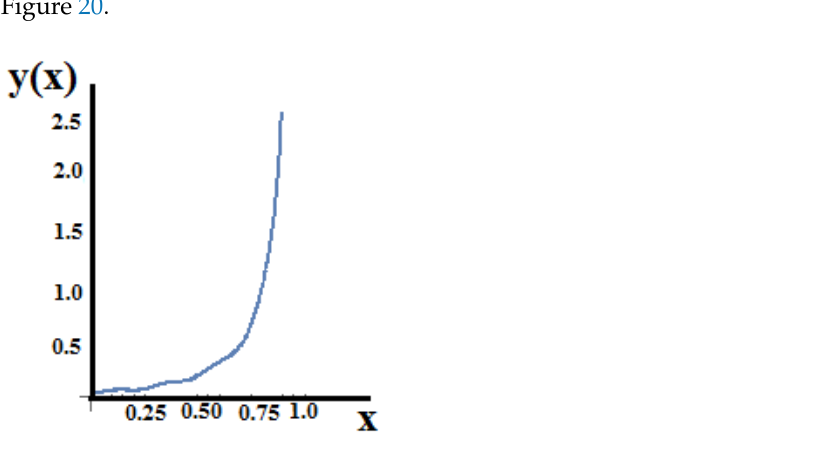
Λ -solutions. Figure 20. The displacement field y ( x ) in the initial space. Figure 20. The displacement field y ( x ) in the initial space. The next step is the interconnection and combination of the left and right fractional Λ